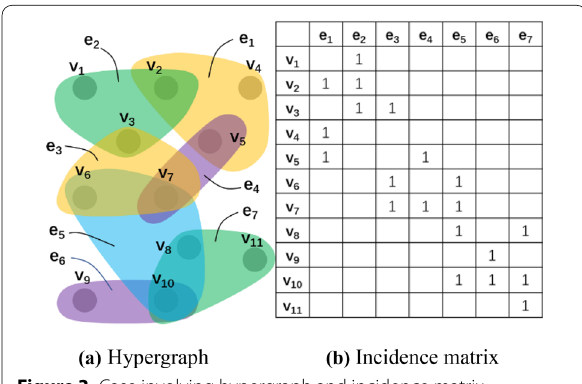
Figure 3 Case involving hypergraph and incidence